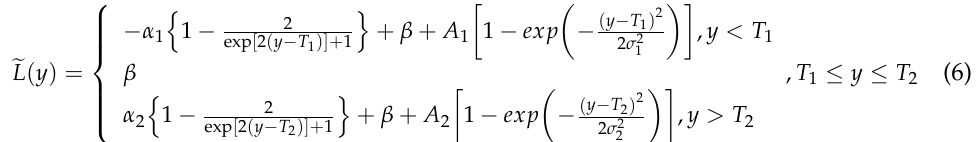
Figure 2. Asymmetric-hyperbolic tangent quality compensation function curve ( β > 0).